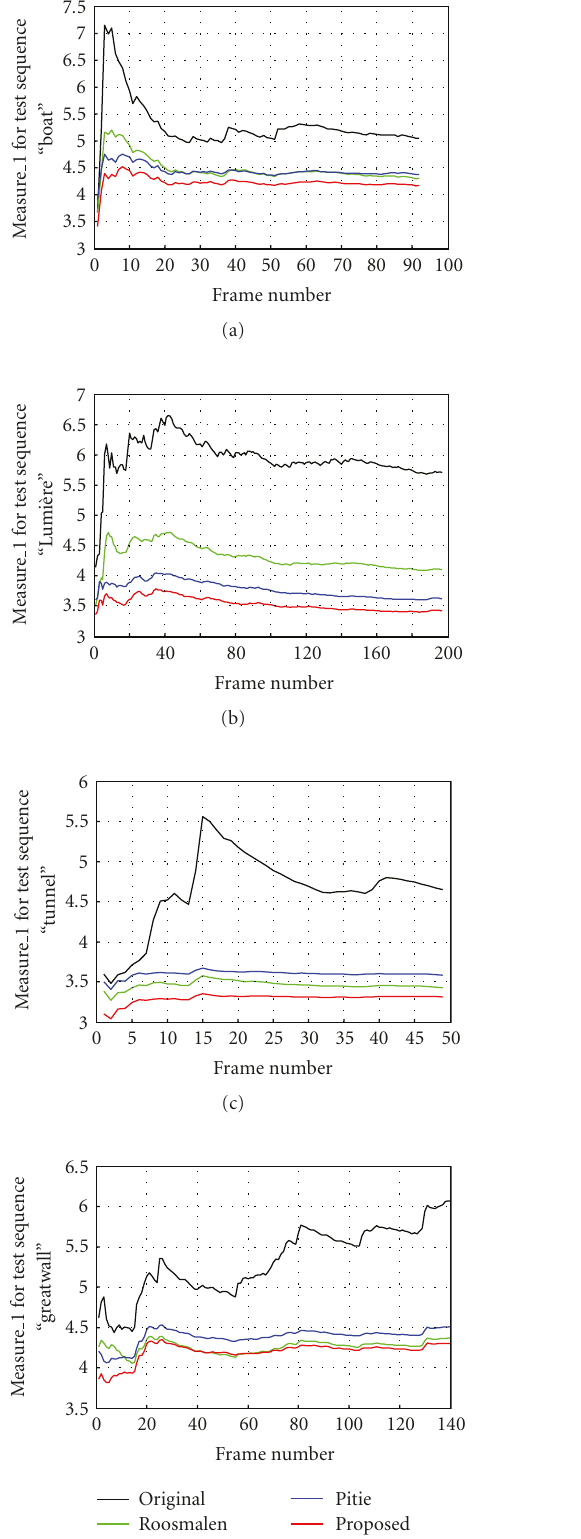
Figure 15: Comparison of time-normalised cumulative average of absolute di ff erences between consecutive motion-compensated frames.